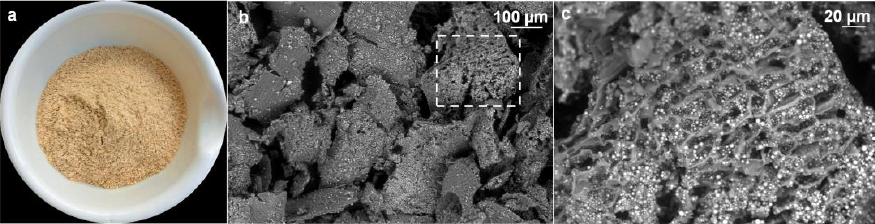
Figure 1. Picture of rice bran ( a ); SEM micrographs of rice bran at 100 × ( b ) and 2500 × ( c ). In ( c ) higher magnification of the boxed region in ( b ) shows aleurone layers with vacuolar inclusions.